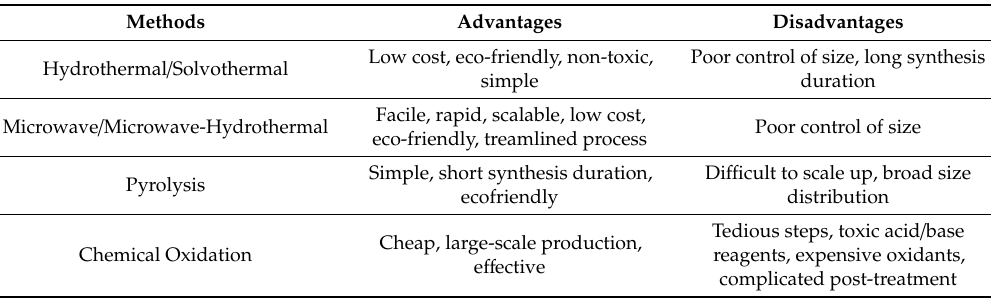
Figure 1. Examples of various plant parts for the synthesis of carbon dots (CDs). Table 1. The features of several methods for the synthesis of plant part-derived CDs.